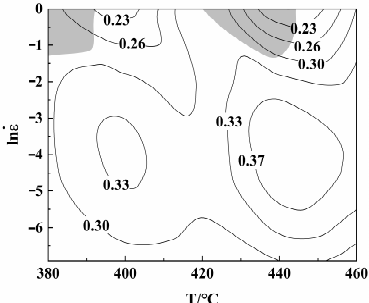
Figure 6. Processing map of the Al−Zn−Mg−Cu alloy at 0.9 strain.